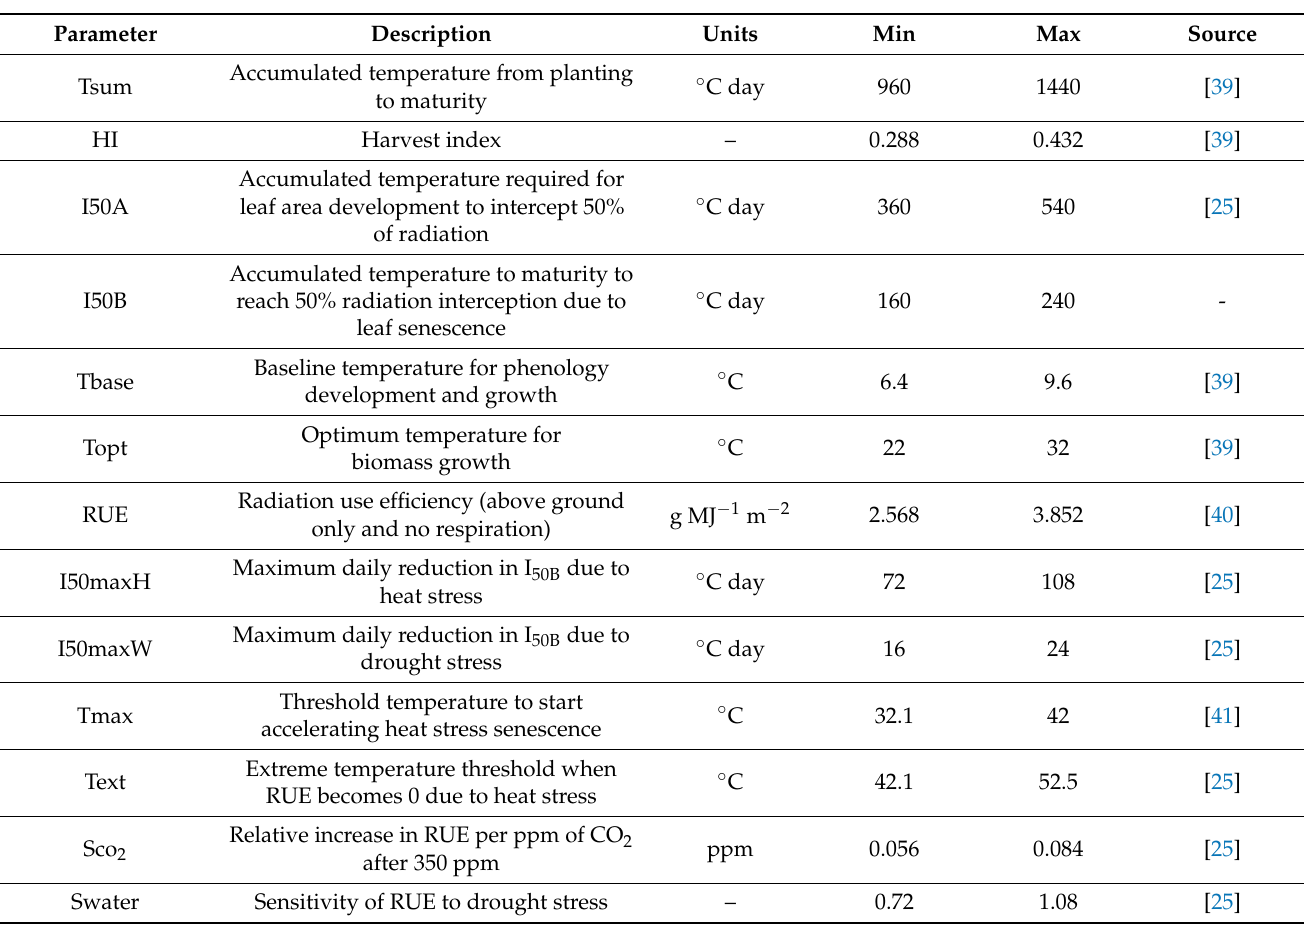
Table 1. Nominal values of the parameters used in the SIMPLE model for the Pinto Saltillo bean variety